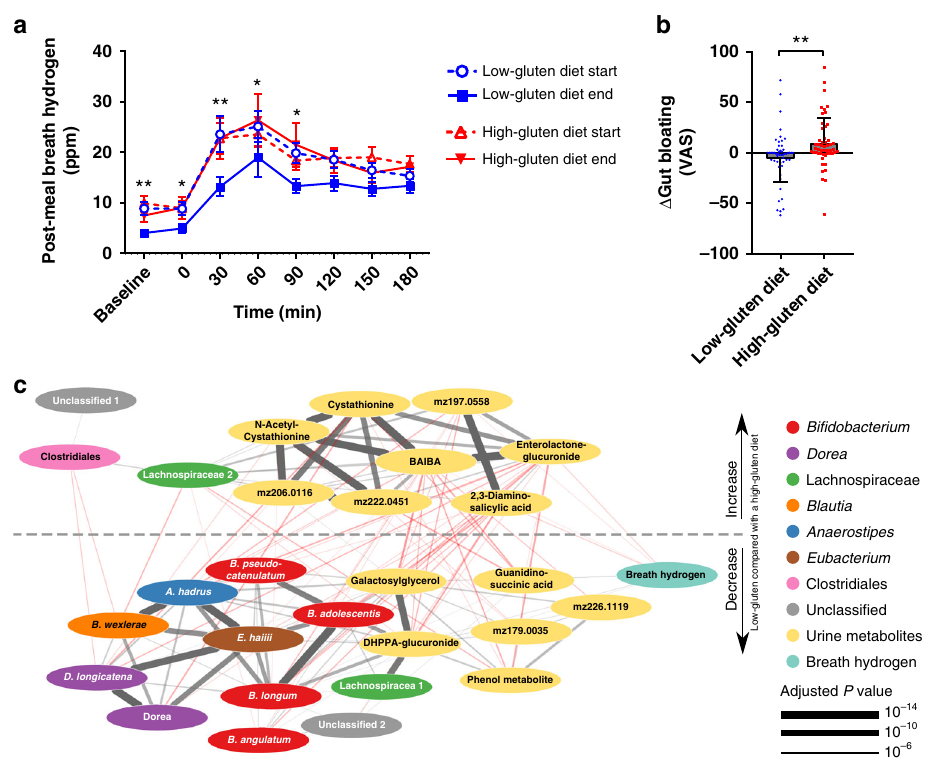
Fig. 4 A low-gluten diet affects measures of intestinal fermentation. a Breath hydrogen levels following the same standardised meal at all four visits (low- gluten diet start, open blue circles; low-gluten diet end, blue squares; high-gluten diet start, open red triangle; high-gluten diet end, fi lled red triangle). Data are shown as means ± SEM (n = 51-57). b Plot showing changes in gut bloating as assessed by visual analogue scale (VAS) following the low-gluten diet (blue circles) compared with the high-gluten diet (red squares). Data are shown as means ± SEM ( n = 52 – 53). Changes were assessed by a linear mixed model adjusting for age, gender and intestinal transit time. * P < 0.05, ** P < 0.01. c Linear regression network of breath hydrogen levels and the abundance of bacterial species and concentrations of urine metabolites which are signi fi cantly responding to the dietary interventions using a linear mixed model adjusted for gender, age and participant ( n = 49) (Supplementary Data 5). The dotted line separates the features that were decreased and increased, respectively, when comparing the low-gluten and high-gluten periods. Signi fi cant (FDR < 0.05) positive associations are indicated with grey lines; negative associations with red lines. Thickness of lines indicates the signi fi cance level. Nodes are coloured according to type; breath hydrogen (cyan), urine metabolites (yellow), Bi fi dobacterium (red), Dorea longicatena (purple), Blautia wexlerae (orange), Eubacterium hallii (brown), Lachnospiracaea (green), Anaerostipes (blue), Clostridiales (pink) and Unclassi fi ed (grey). m/z refers to the mass-to-charge ratio of a given unidenti fi ed urine metabolite. BAIBA β